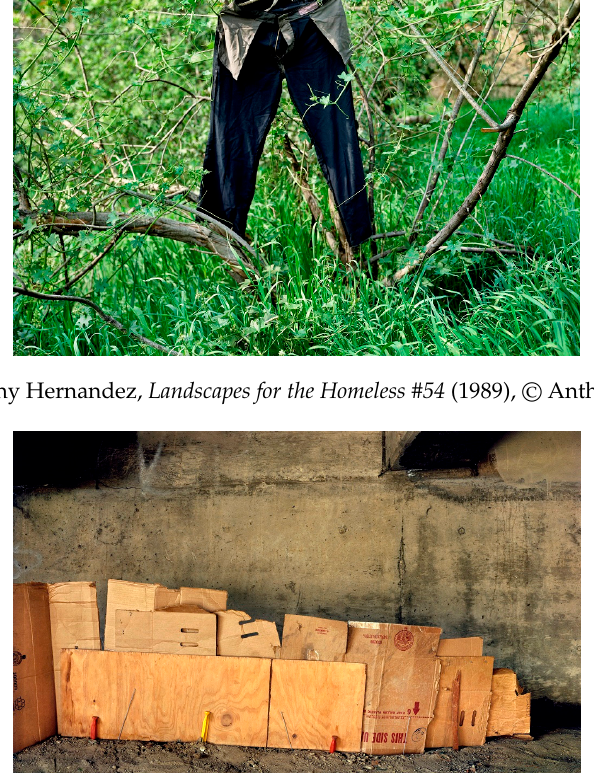
Figure 5. Anthony Hernandez, Landscapes for the Homeless #54 (1989), © Anthony Hernandez.